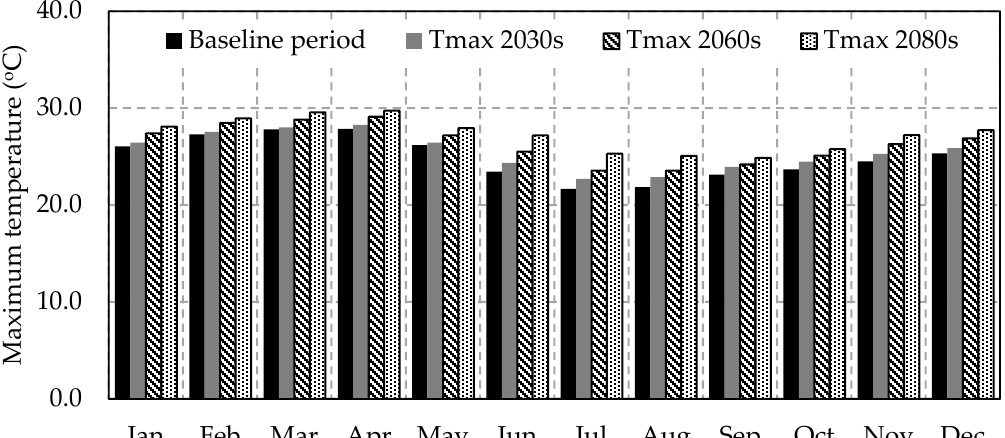
Figure 7. Long ‐ term average monthly maximum temperature for baseline period and future time horizons (2030s, 2060s and 2080s) in the Main Beles and Gilgel Beles subbasins.